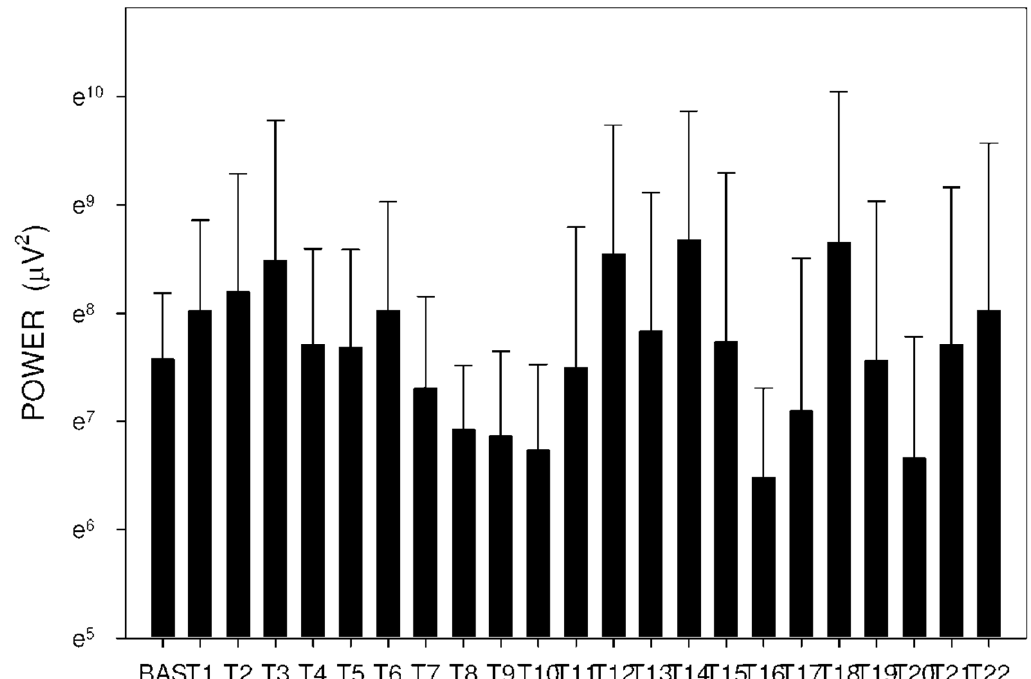
Figure 12. Electrogastrography power after a single intragastric dose of 10 mg of donepezil (group B). Outliers omitted. Y axis: natural log scale.